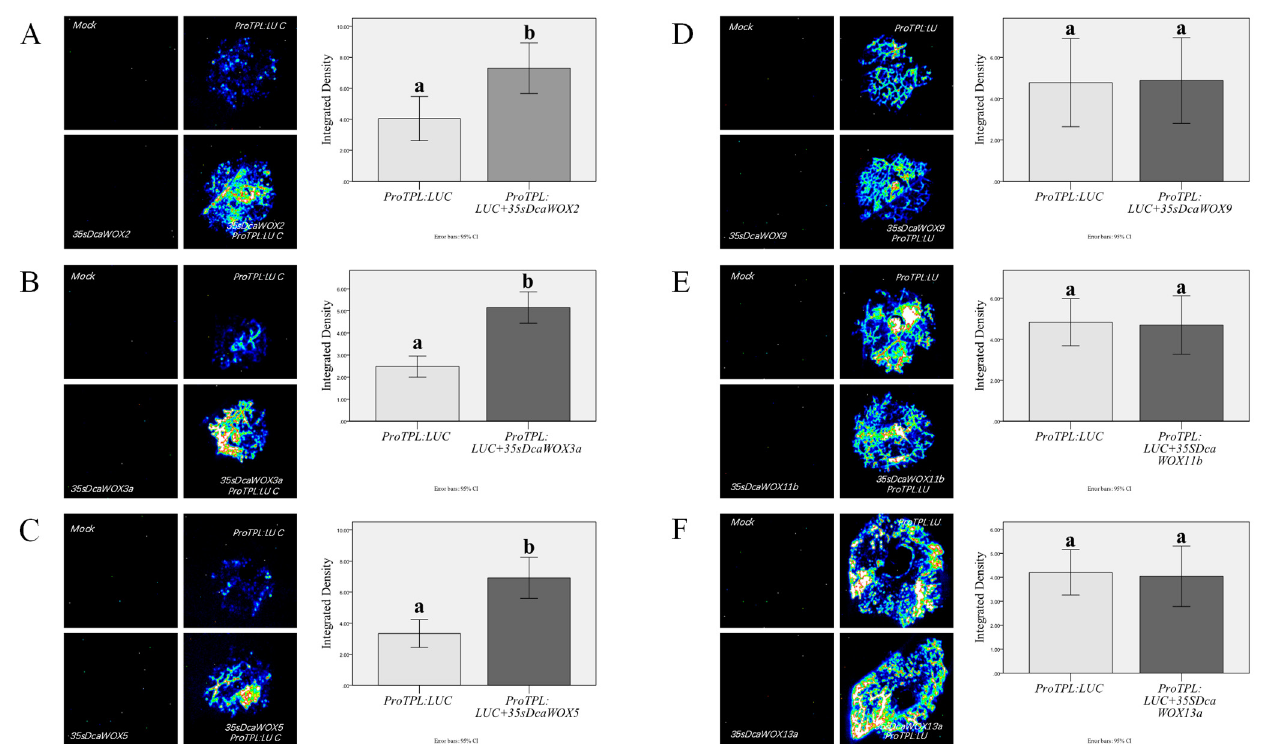
Figure 4. Analysis of the effects of DcaWOX2, DcaWOX3a, DcaWOX5, DcaWOX9, DcaWOX11b, and DcaWOX13a. TPL expression was activated by ( A ) DcaWOX2, ( B ) DcaWOX3a, and ( C ) DcaWOX5. TPL expression was not activated by ( D ) DcaWOX9, ( E ) DcaWOX11b, and ( F ) DcaWOX13a. a, b indicates significant differences among treatments ( n = 5).